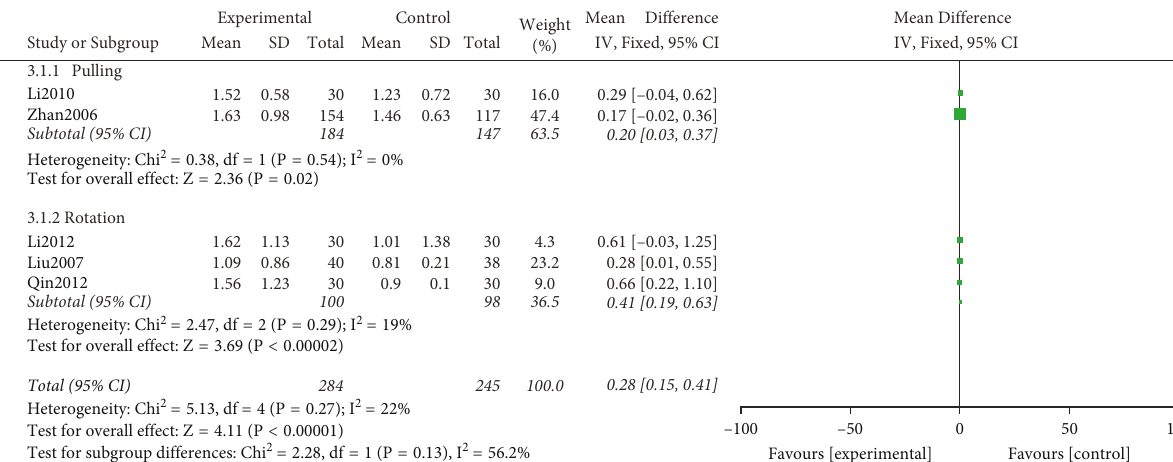
Figure 7: Comparison between the mean difference scores before and after treatment of symptom scores (neck pain) of manipulation and cervical traction in the treatment of